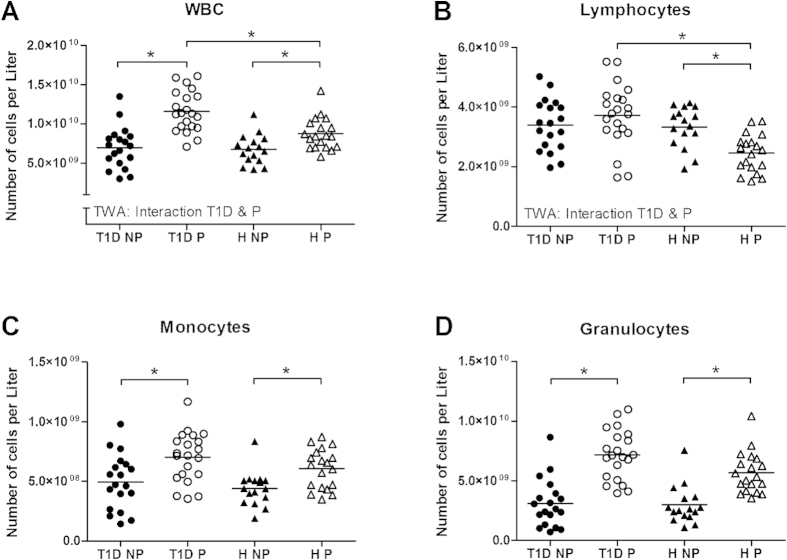
WBC (A), lymphocytes (B), monocytes (C) and granulocytes (D) in non-pregnant (NP) and pregnant (P) women with type 1 diabetes (dotted line) and healthy women (continuous line). *Significant difference between the marked groups, independent T-test, p < 0.05. I: Significant interaction between diabetes and pregnancy, p < 0.05, two-way ANOVA.